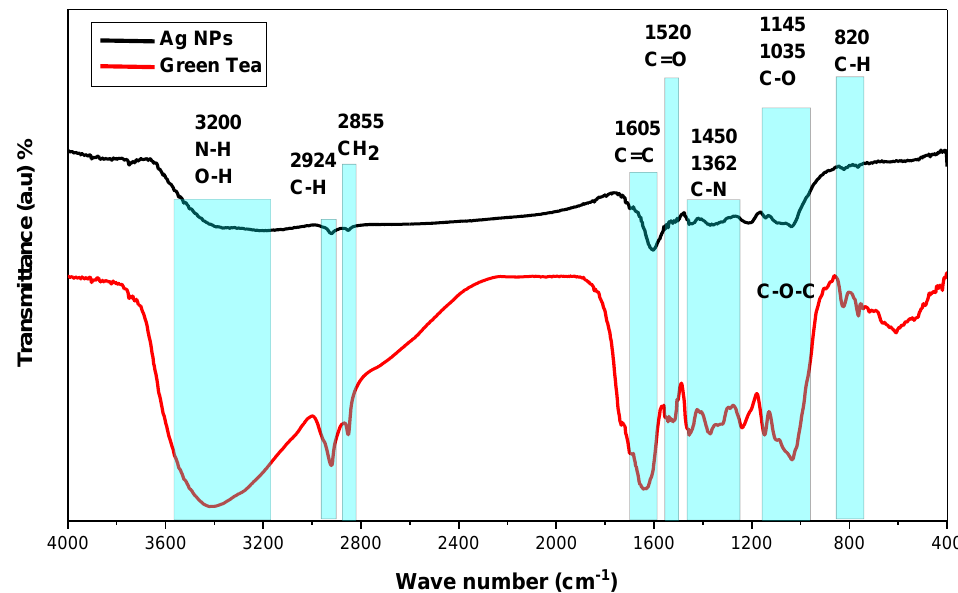
Figure 4. FTIR spectra for GT and biosynthesized Ag NPs and GT.